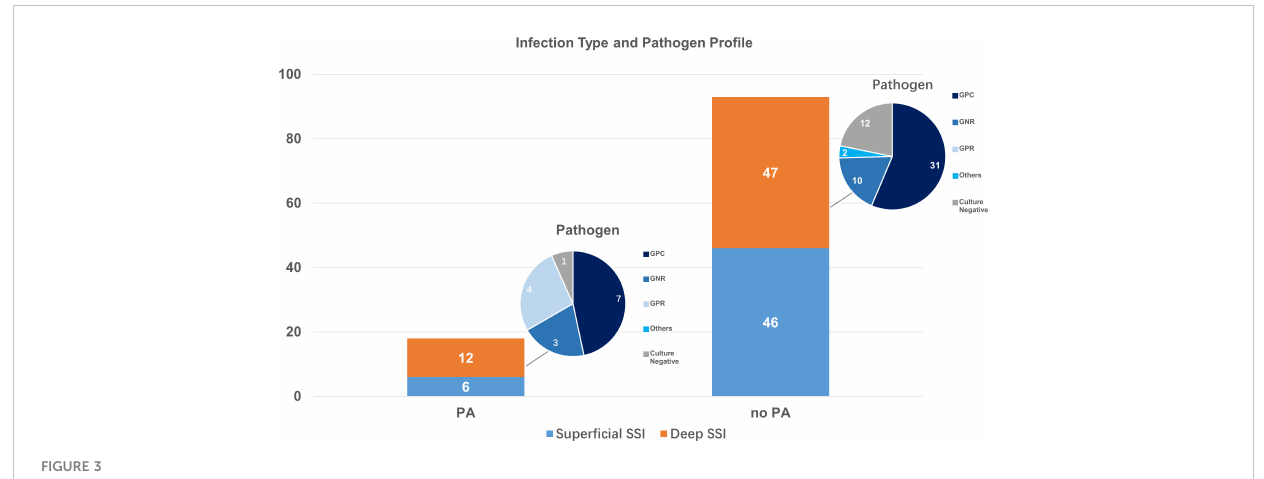
FIGURE 3 Pathogen pro fi le of deep SSI in PA and Non-PA